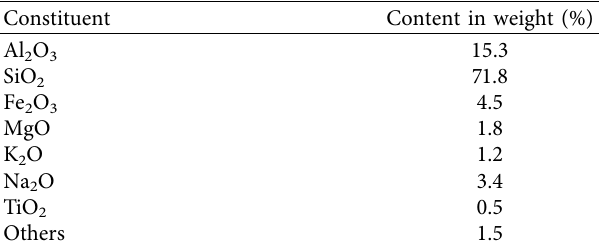
Figure 1: X-ray diffraction pattern of bentonite (radiation source, CuK α ; wavelength, 0.15406nm; diffraction angle, from 3 ° to 60 ° ; the scanning step, 0.02 ° /min). Table 2: Chemical compositions of